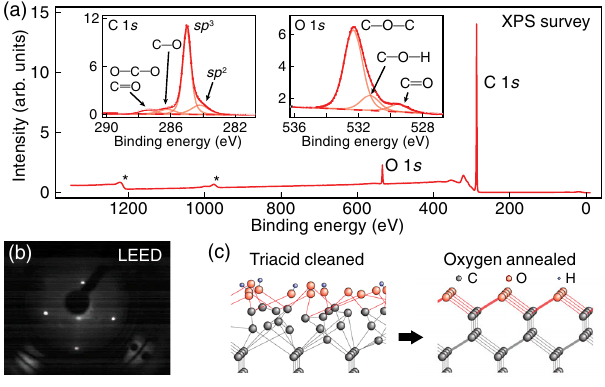
FIG. 4. Detailed characterization of the oxygen-annealed sur- face. (a) XPS survey scan showing dominant carbon and oxygen peaks. Peaks marked with * are Auger peaks associated with carbon and oxygen. Left-hand inset: High-resolution XPS carbon 1 s spectrum showing a dominant diamond sp 3 peak with three side peaks assigned to sp 2 carbon, and carbon singly and doubly bonded to oxygen. Right-hand inset: High-resolution XPS oxy- gen 1 s spectrum showing a dominant ether (C ─ O ─ C) peak and two satellite peaks assigned to alcohol (C ─ O ─ H) and ketone (C ═ O). (b) LEED pattern showing a 1 × 1 reconstruction of the oxygen-annealed surface, consistent with ether termination. (c) Ball-and-stick diagrams illustrating the surface termination before and after oxygen annealing. The disordered, acid-cleaned surface hosts a mixture of groups, which transform into a highly ordered, predominantly ether-terminated surface upon oxygen